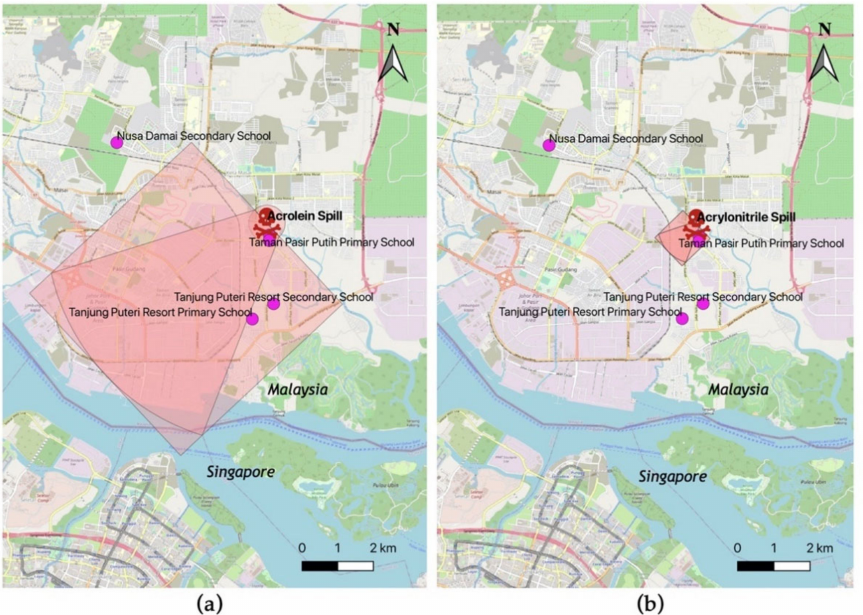
Figure 5. WISER protective distance: ( a ) Protective distance for acrolein, ( b ) protective distance for acrylonitrile.